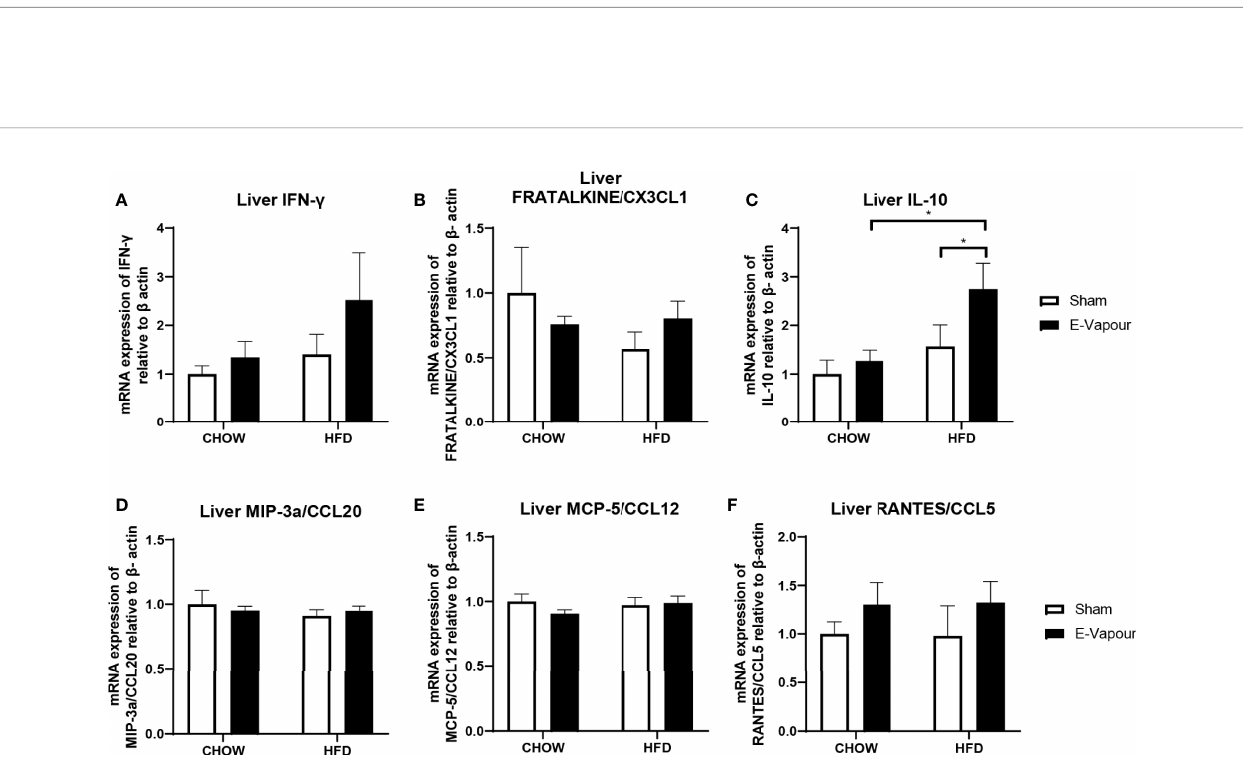
FIGURE 3 | mRNA expression of IFN- g (A) , FRACTALKINE/CX3CL1 (B) , IL-10 (C) , MIP-3a/CCL20 (D) , MCP-5/CCL12 (E) , and RANTES/CCL5 (F) in the liver. Results are expressed as mean ± SEM, n=5-7. *P <